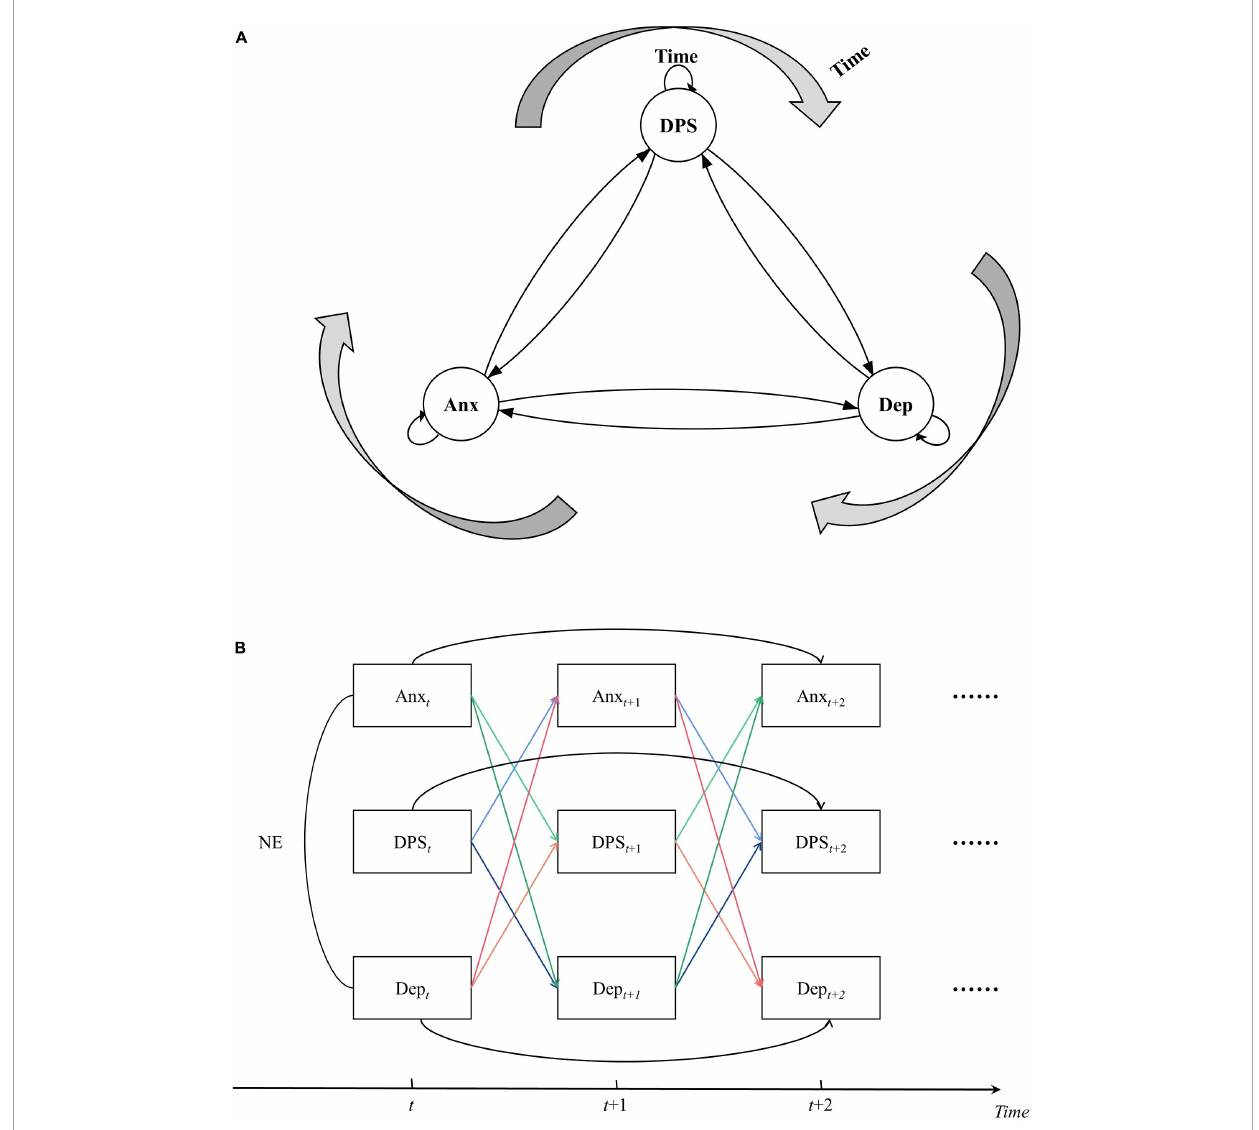
FIGURE1 (A) A downward-spiral model, presenting a trajectory of change of daily perceived stress, anxiety and depression. DPS, daily perceived stress; Anx, anxiety; Dep, depression. (B) The paths of the downward spiral model. DPSt, daily perceived stress at t ; Anxt, anxiety at t ; Dept, depression at t ; NE, negative emotion.